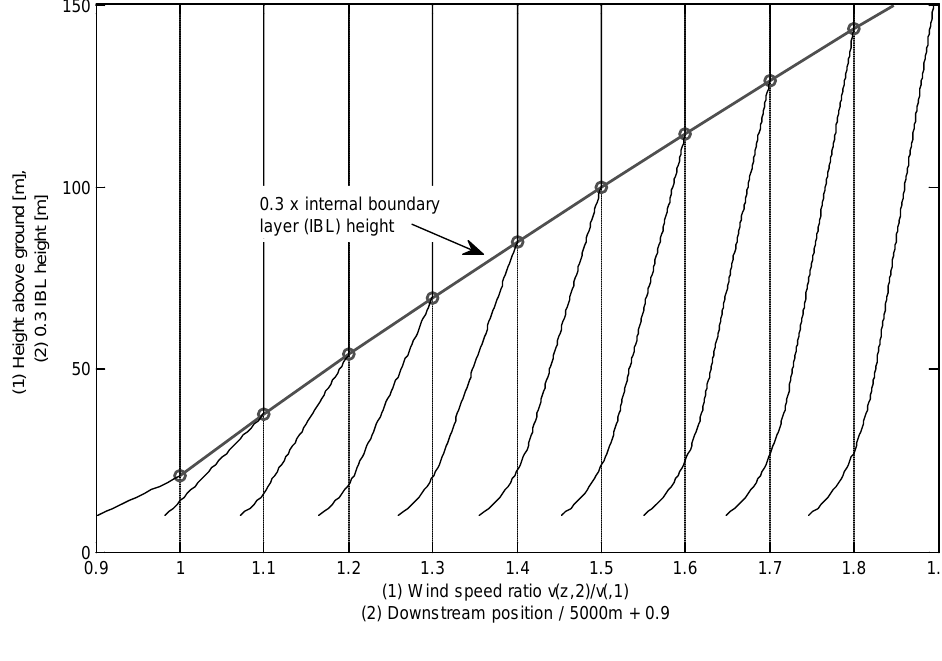
Figure 19. Evolution of the ratio of the vertical wind speed profiles before and after a change in roughness length as a function of the distance from the discontinuity. The wind profiles have been offset horizontally for clarity. The evolution of the internal boundary layer has been shown for